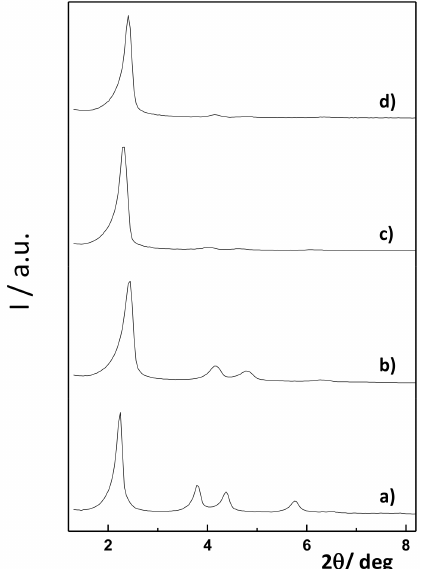
Figure 1. Powder X-ray patterns of ( a ) mesostructured mesoporous silica particles as-made, ( b ) cal- cined mesoporous silica, ( c ) MCM-Saf-N3, and ( d ) MCM-Met-N3. Table 1. Diffraction reflections of mesostructured mesoporous silica particles as-made,